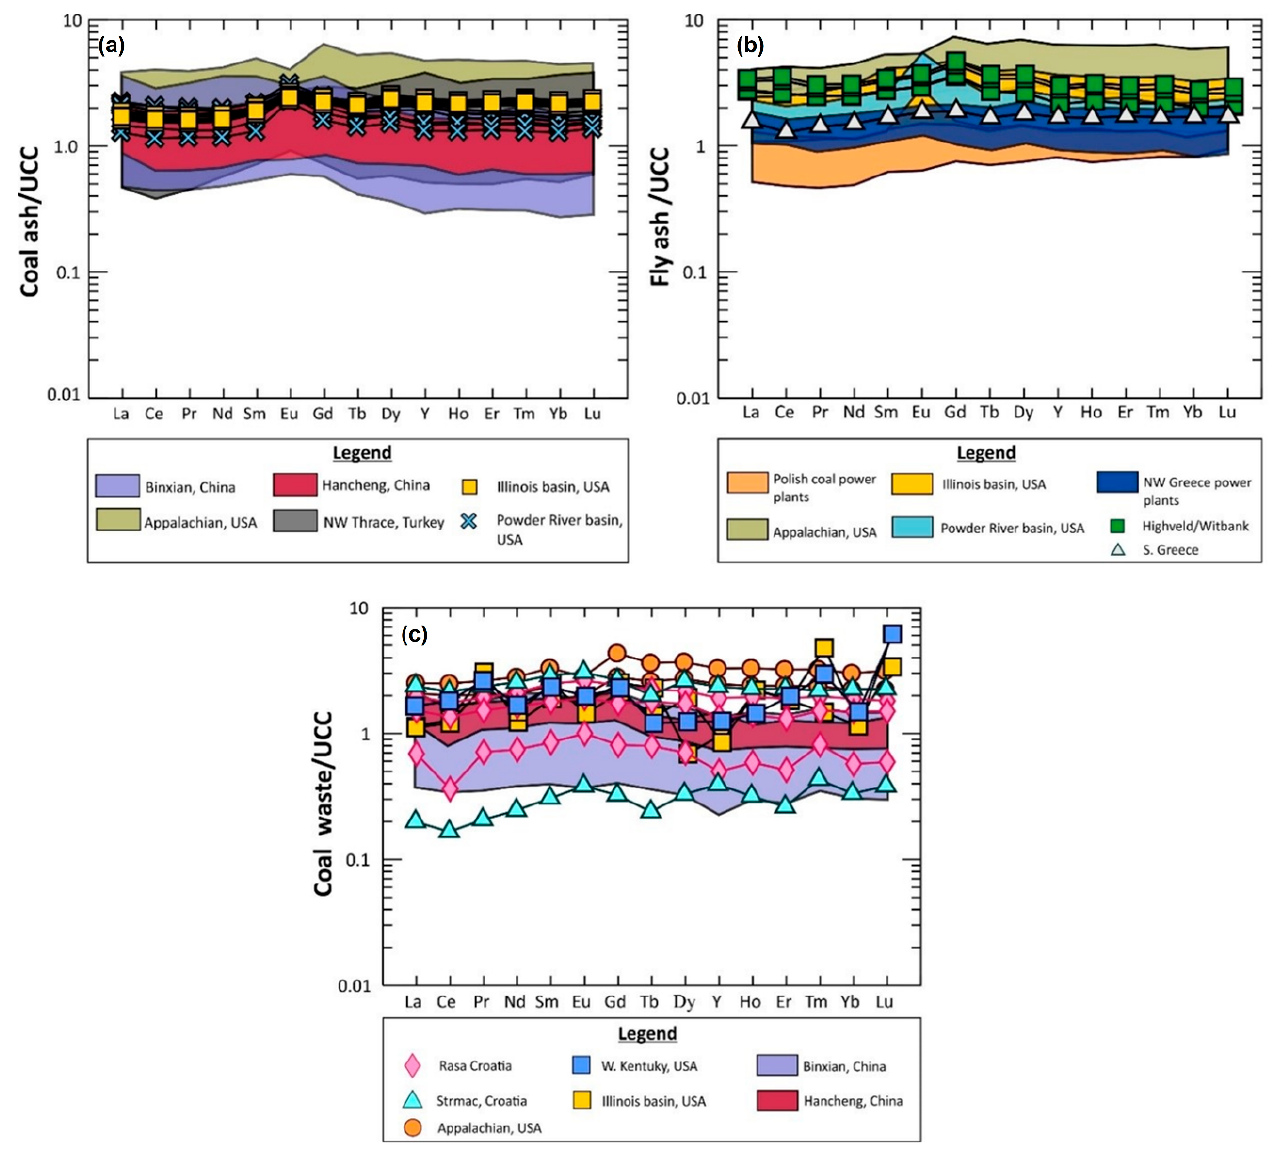
Figure 2. Upper Continental Crust (UCC) normalised-REE patterns of: ( a ) coal ash [22,23,27], ( b ) fly ash [13,23], ( c ) coal waste [18,22,23,29]. Normalisation factors after Taylor and McLennan [15] .